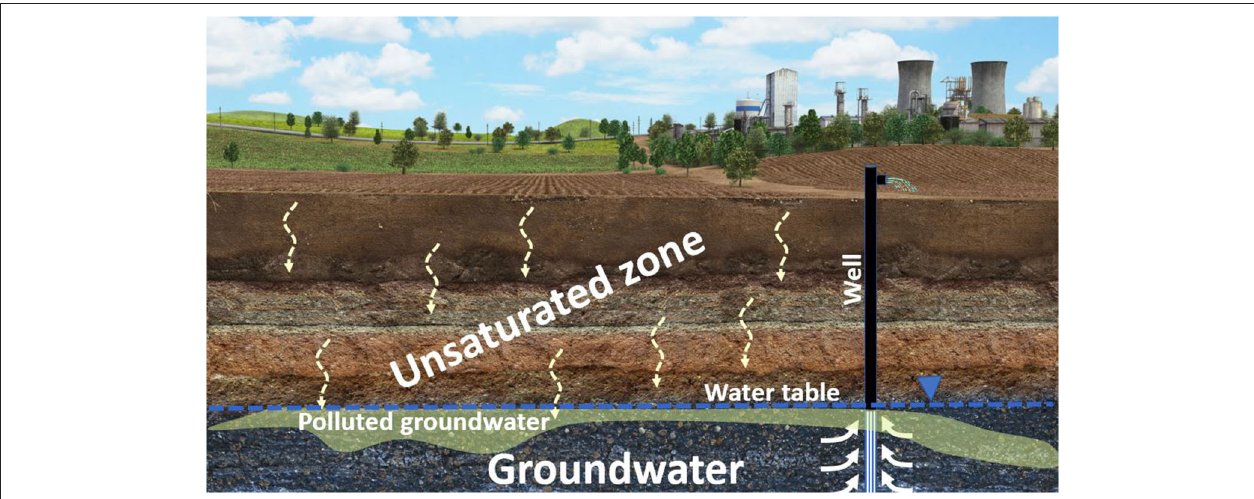
FIGURE 1 | Illustration of the subsurface hydrological domains. The figure emphasizes the link between water infiltration and contaminant transport through the unsaturated zone to the groundwater